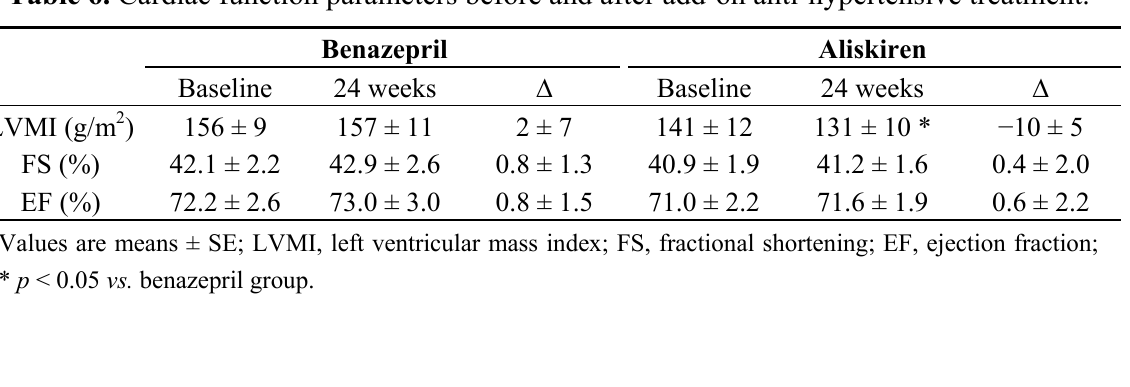
Table 6. Cardiac function parameters before and after add-on anti-hypertensive